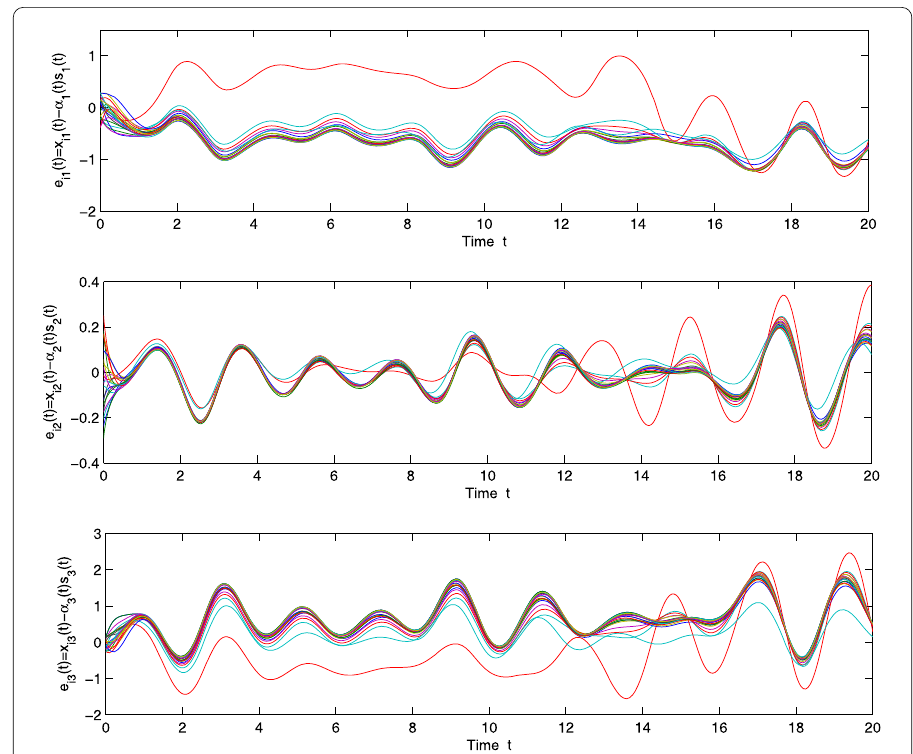
Figure 16 The modified function projective synchronization errors between the states of isolate node α ( t ) s ( t ) (38) and node x i ( t ) (39) with Watts-Strogatz network, where e ij ( t ) = x ij ( t ) – α j ( t ) s j ( t ) for i = 1,...,20, j = 1,2,3, without hybrid adaptive pinning